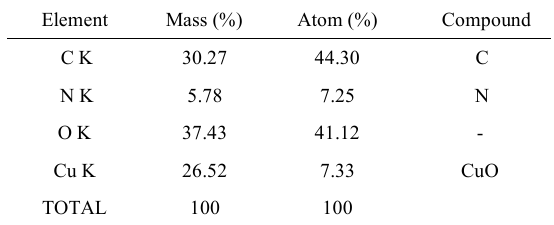
Table 5. Element percentage of CuONPs